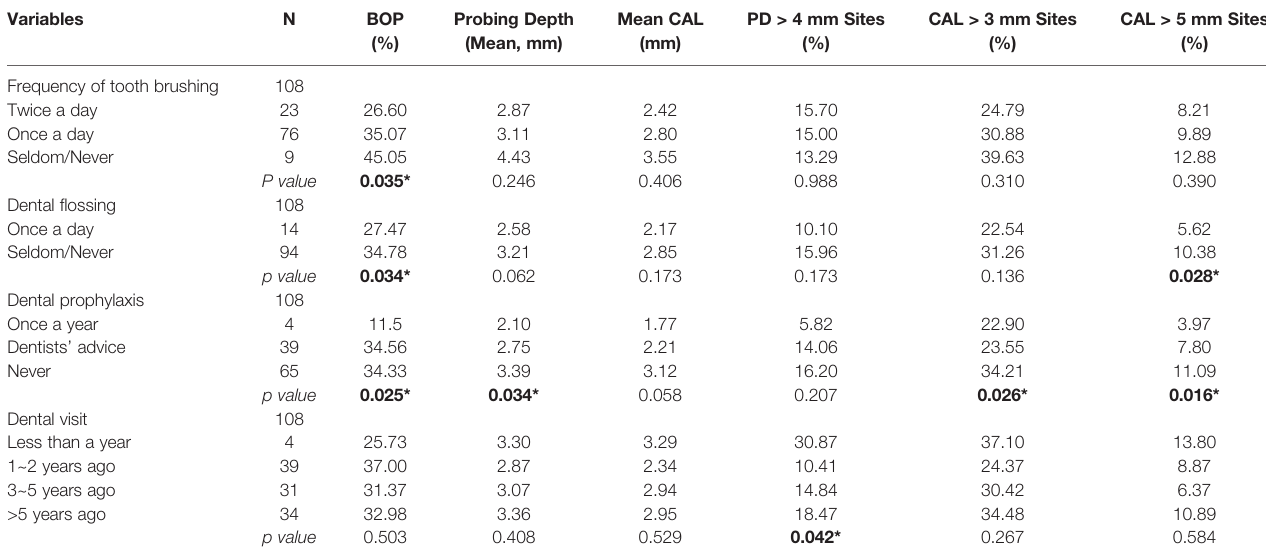
TABLE 2 | Effect of oral health care behaviors on periodontal clinical indicators in HIV-infected patients, n = 108.